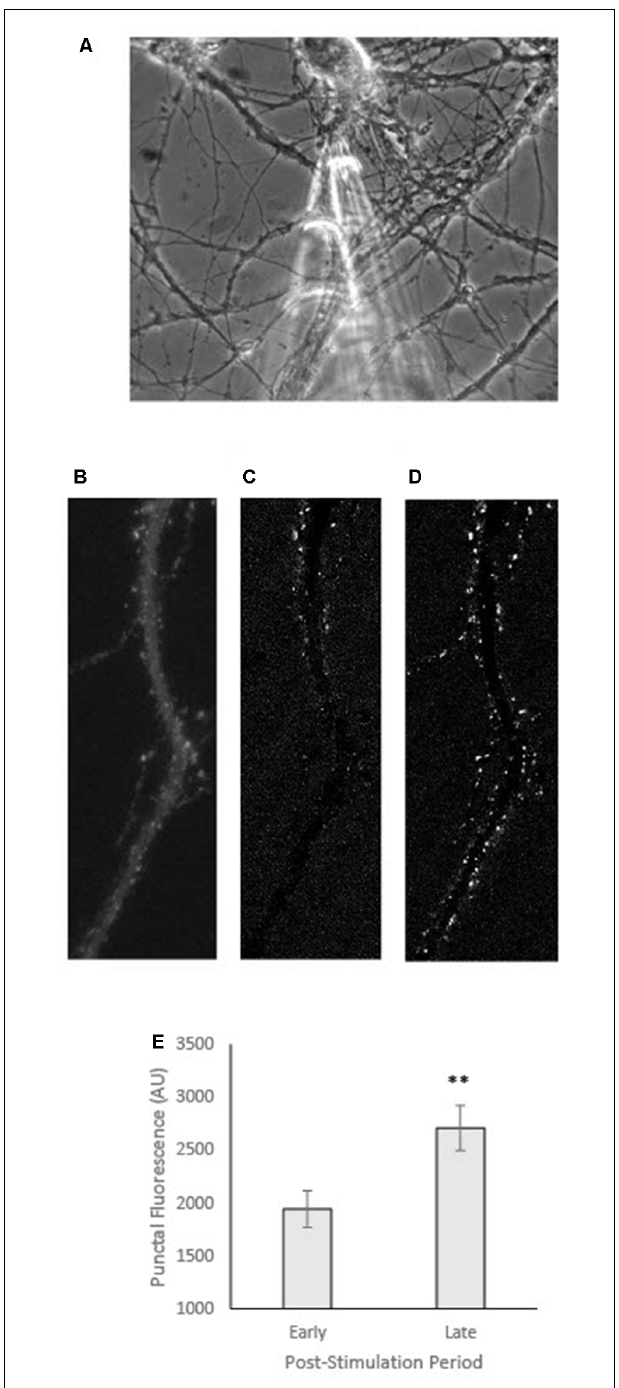
FIGURE 3 | GFP-CaMKII translocation following local stimulation in neurons co-transfected with T286A. (A) Phase image of representative neuron showing micropipette captured prior to local stimulation. (B) GFP-CaMKII expression in the same neuron in (A) prior to stimulation. (C) Subtraction image (current fluorescence level minus initial fluorescence level; increases in fluorescence appear whiter while decreases are darker/black) captured within 60 s of local stimulation (early). (D) Subtraction image at 360 s post-stimulation (late). (E) Fluorescence intensity measured at an early (60 s) vs. late (360 s) time point following local stimulation. ∗∗ p <